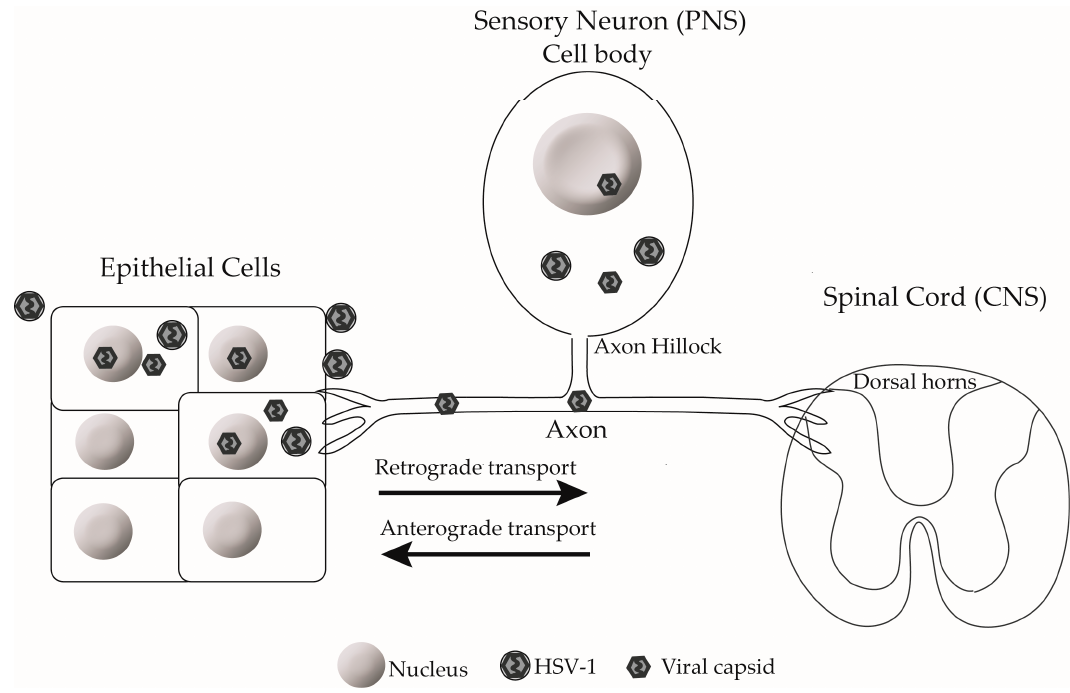
Figure 1. Herpes simplex virus type 1 (HSV-1) life cycle in the human host. After primary infection in the epidermis, HSV-1 enters sensory nerves innervating the skin or mucosa and undergoes retrograde axonal transport to the neuronal cell body where it establishes a life-long latent infection within sensory neurons. During reactivation, HSV-1 travels via anterograde axonal transport towards the peripheral epidermis to cause recurrent herpes or to be asymptomatically shed.